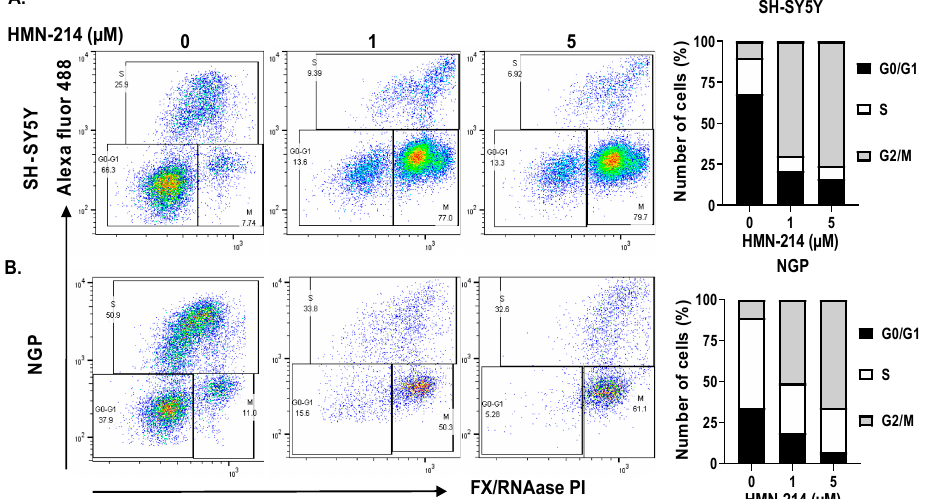
Figure 5. HMN-214 blocks cell cycle in NB. Cell cycle assay performed in response to HMN-214 treatment in both MYCN-non-amplified (SH-SY5Y) and MYCN-amplified (NGP) cell line. ( A , B ) Representative flow cytometer images and quantitation of the percentage of cells in different cell cycle phases. ( A ) SH-SY5Y, ( B ) NGP.